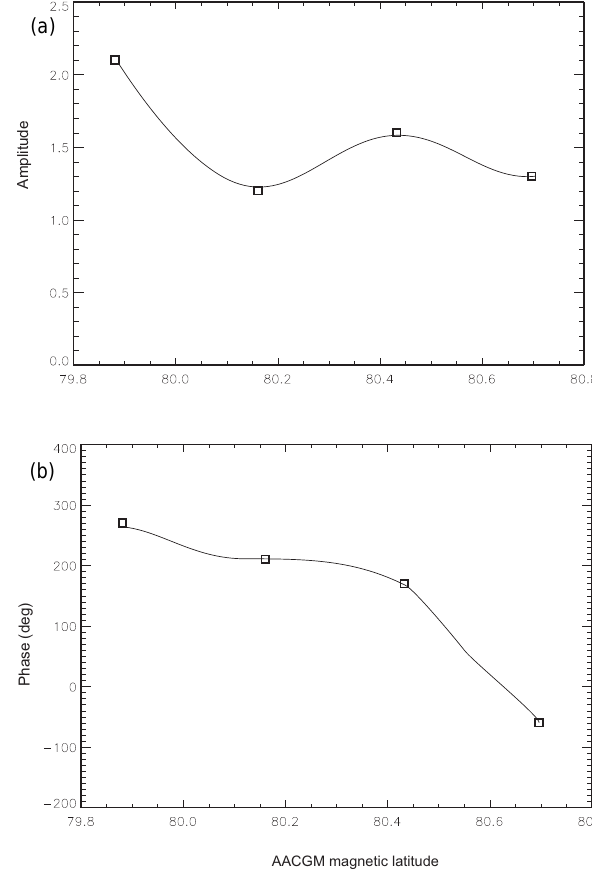
Figure 2. Latitude profile of amplitude and phase along beam 2 (beam aligned closely with the magnetic meridian) of Þykkvibær for event 2.